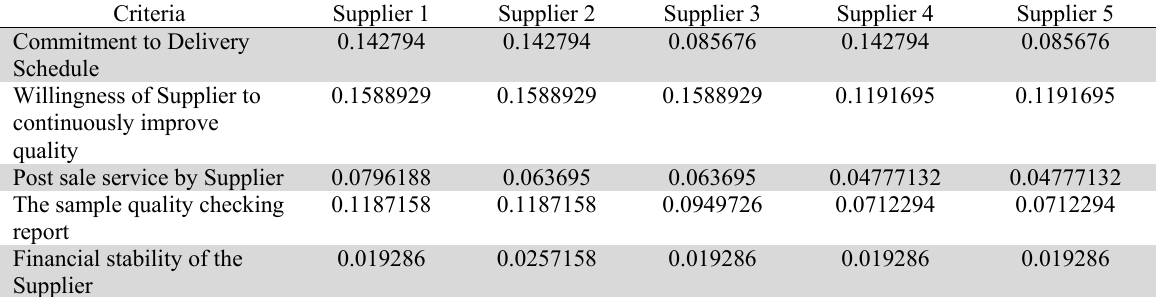
Weighted Standardized Decision Matrix